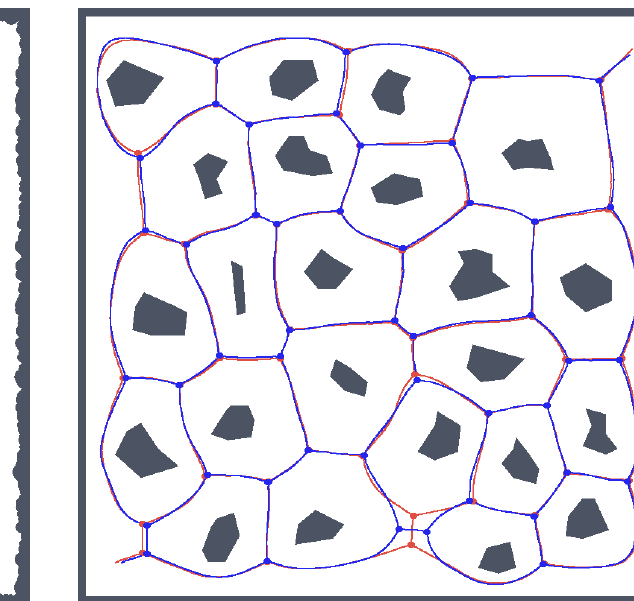
Figure 15. Determined skeletons and topological maps with highlighted junction places and leaves in the map potholes with the noise level σ = 0 : ( a ) RD-based Voronoi diagram; ( b ) and its corresponding skeleton superimposed on the skeleton determined in the noise-less map (in red); ( c ) Pruned GVG representing skeleton of the map determined by the thinning algorithm [12]; ( d ) and the corresponding skeleton superimposed on the skeleton determined in the noise-less